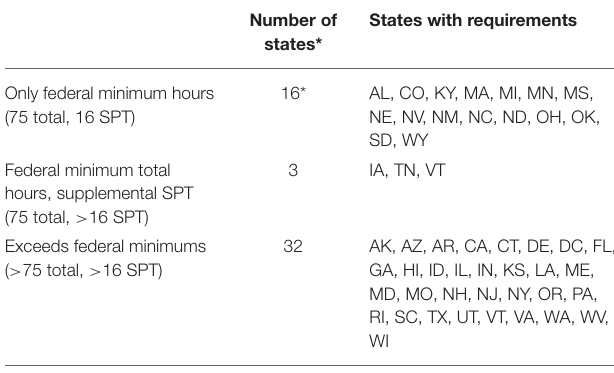
TABLE 1 | Demographic characteristics of certified nursing aides (CNAs) in 2004 compared to 2019. Demographic characteristics of CNAs